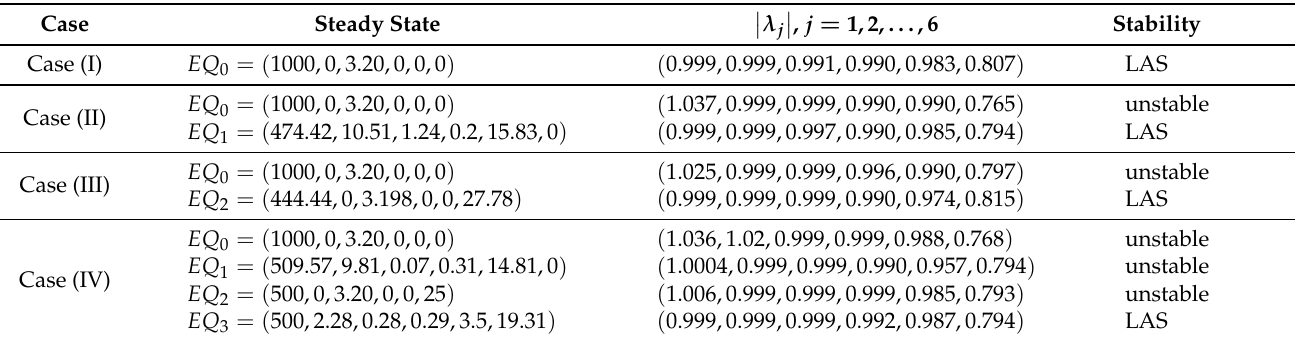
Table 2. Local stability of